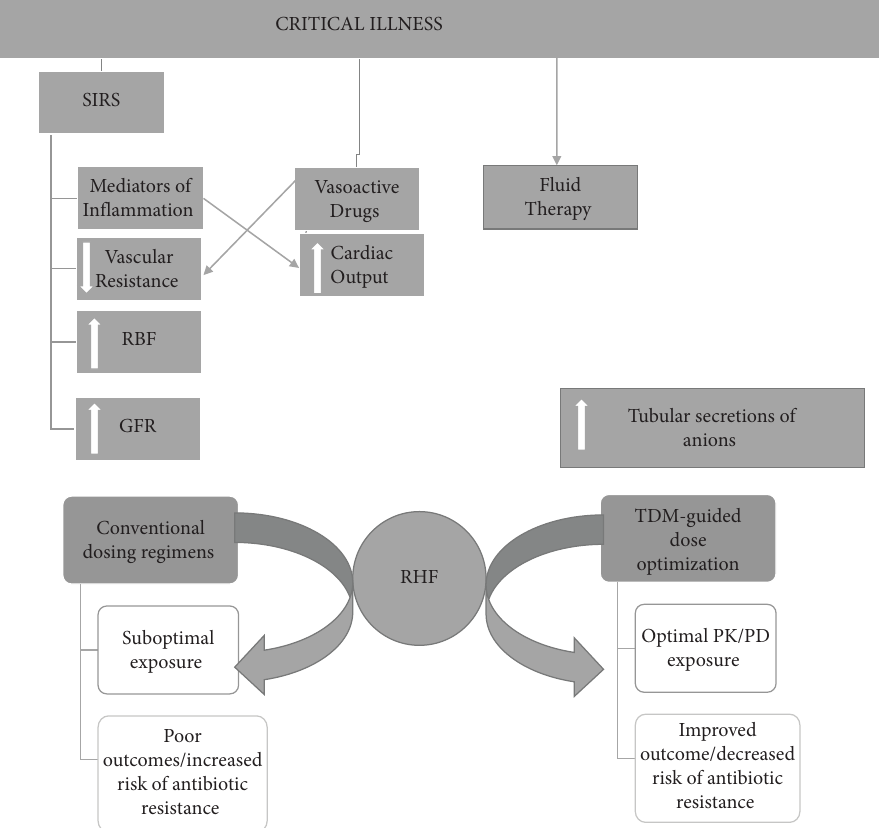
Figure 1: Causes and consequences of augmented renal clearance in critically ill patients. RBF: renal blood fow, GFR: glomerular fltration rate, TDM: therapeutic drug monitoring, PK/PD: pharmacokinetics/pharmacodynamics, SIRS: systemic infammatory response syndrome. Modifed from Sime FB